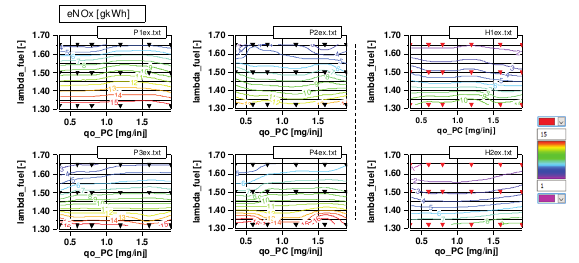
Fig. 16. The NO x emission maps obtained for prechamber type P (a) and type H (b)